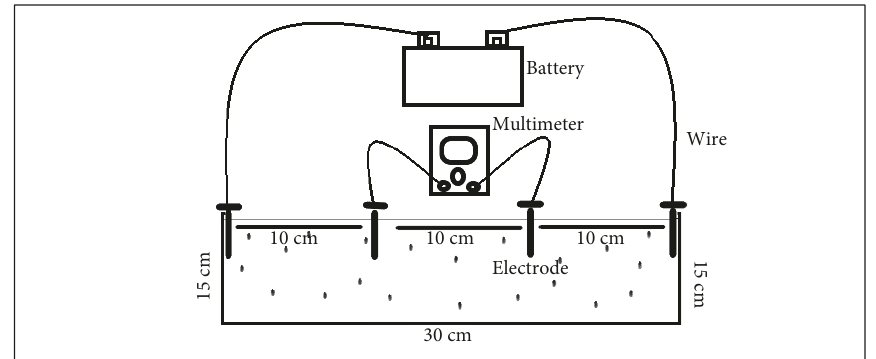
Figure 3: Wenner soil resistivity laboratory test